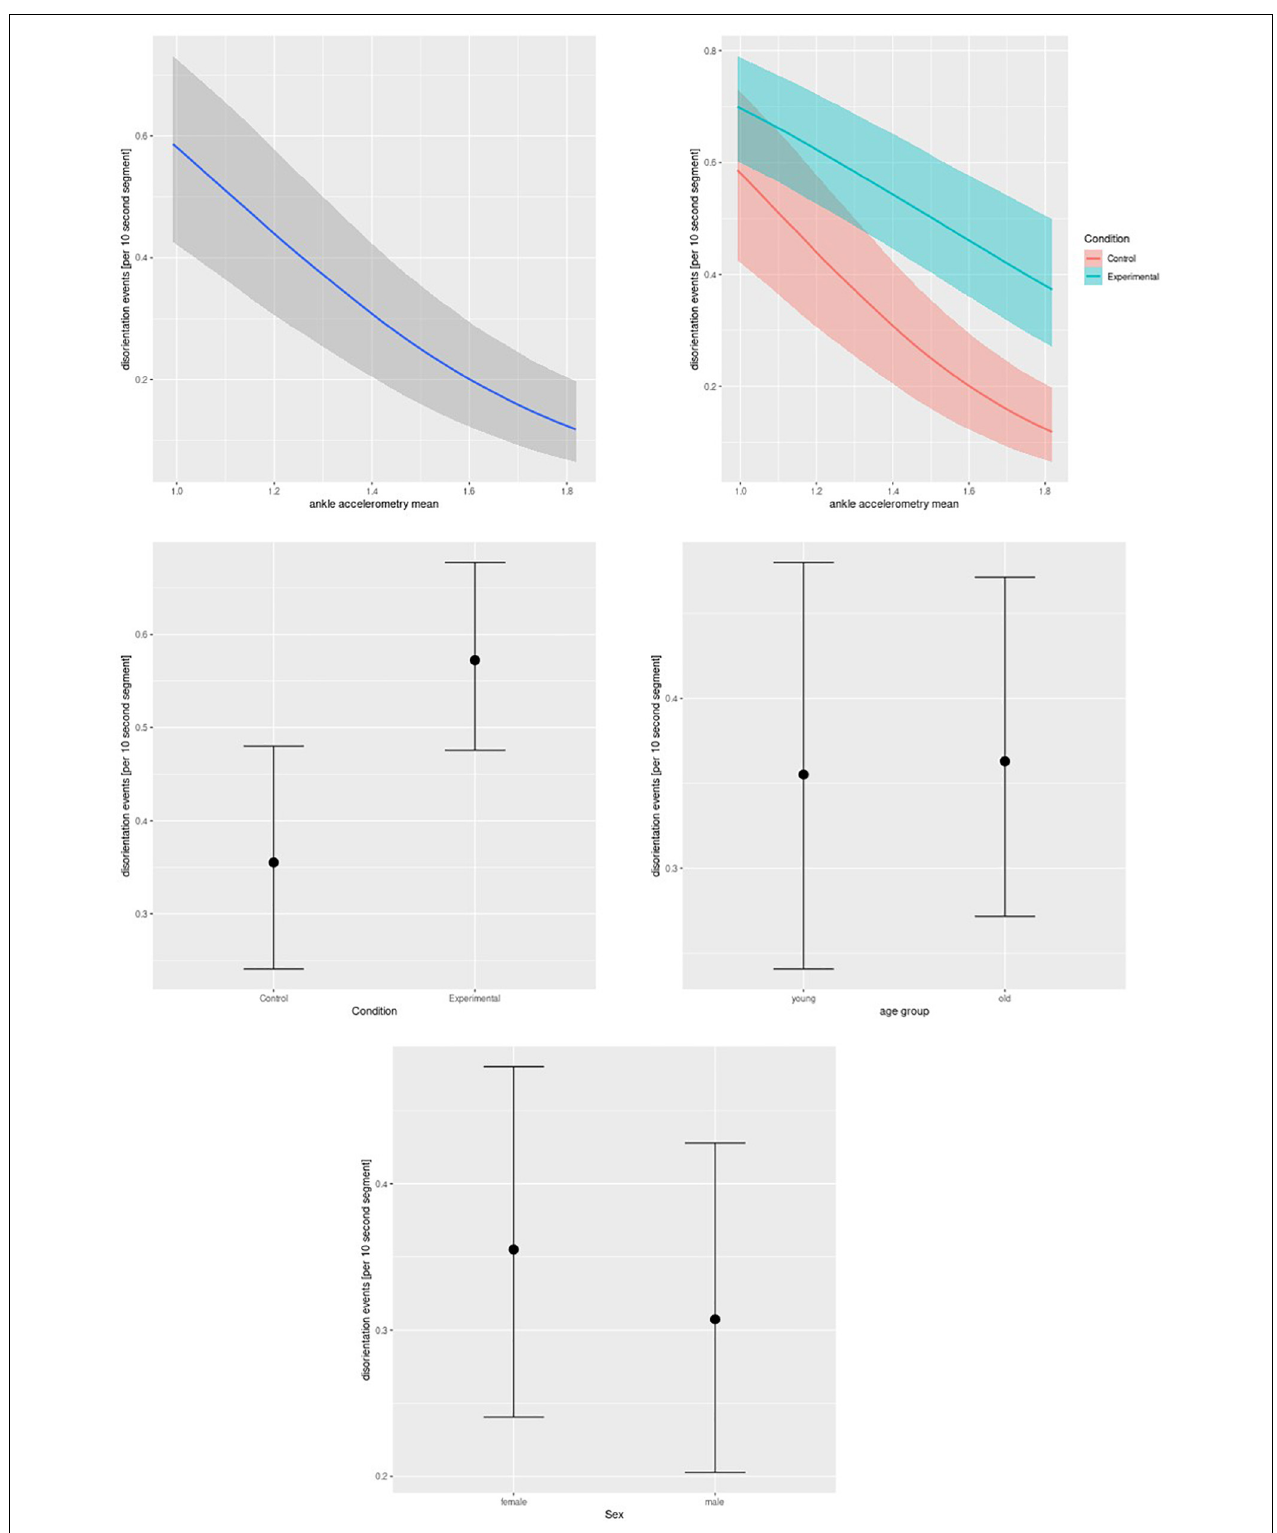
FIGURE 2 | Real-time data, ankle worn accelerometry. Bayesian mixed-effect logistic regression of disorientation events on ankle worn accelerometric signal (main effect, upper left and interaction effect with condition, upper right), condition (experimental or control, middle left), age group (middle right), and gender (lower row). The graphs feature mean effects and 95% credibility